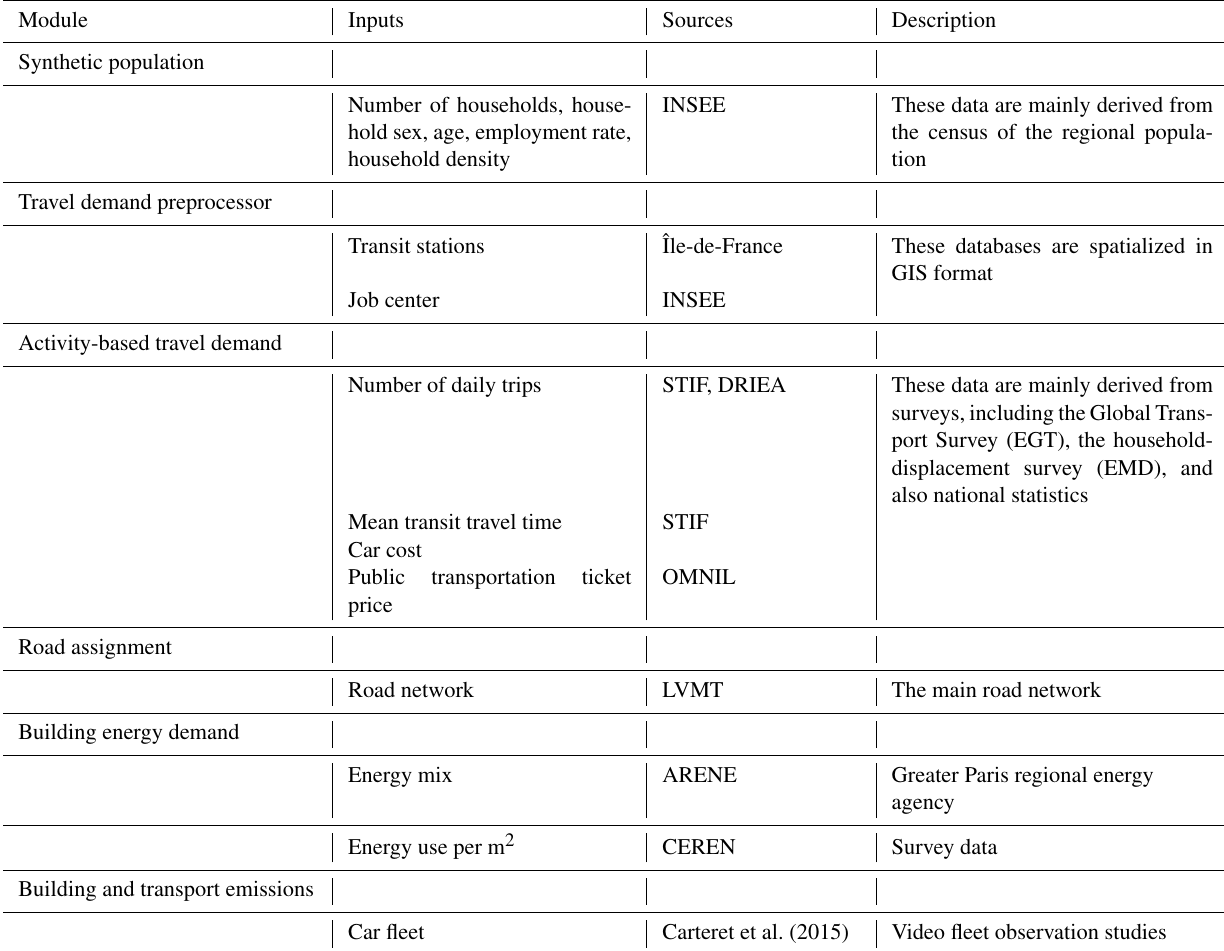
Table 1. OLYMPUS parameterization for the greater Paris